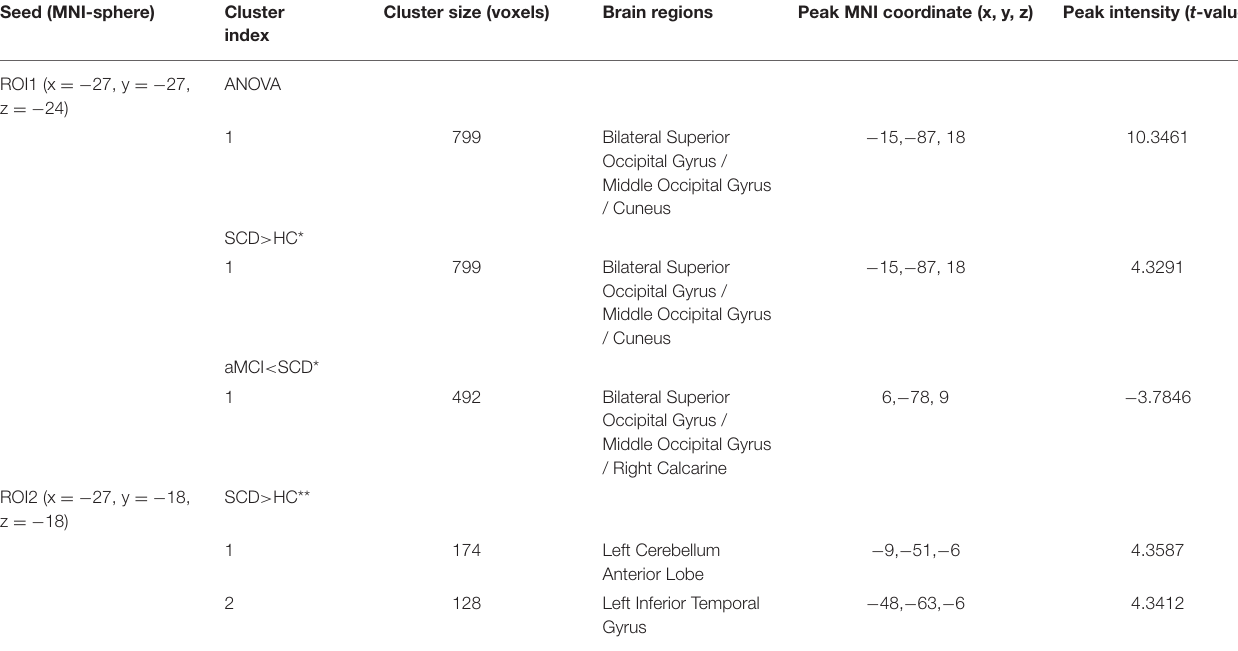
128 Left Inferior Temporal Gyrus